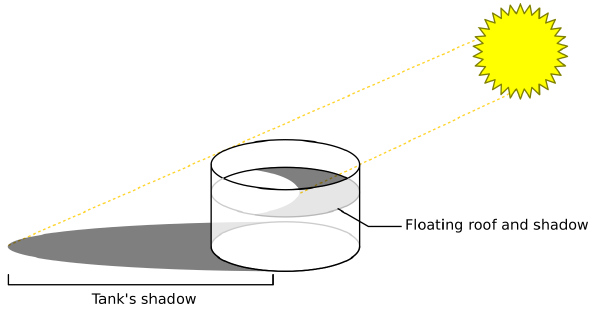
Figure 2. Shadows in floating roof tanks.